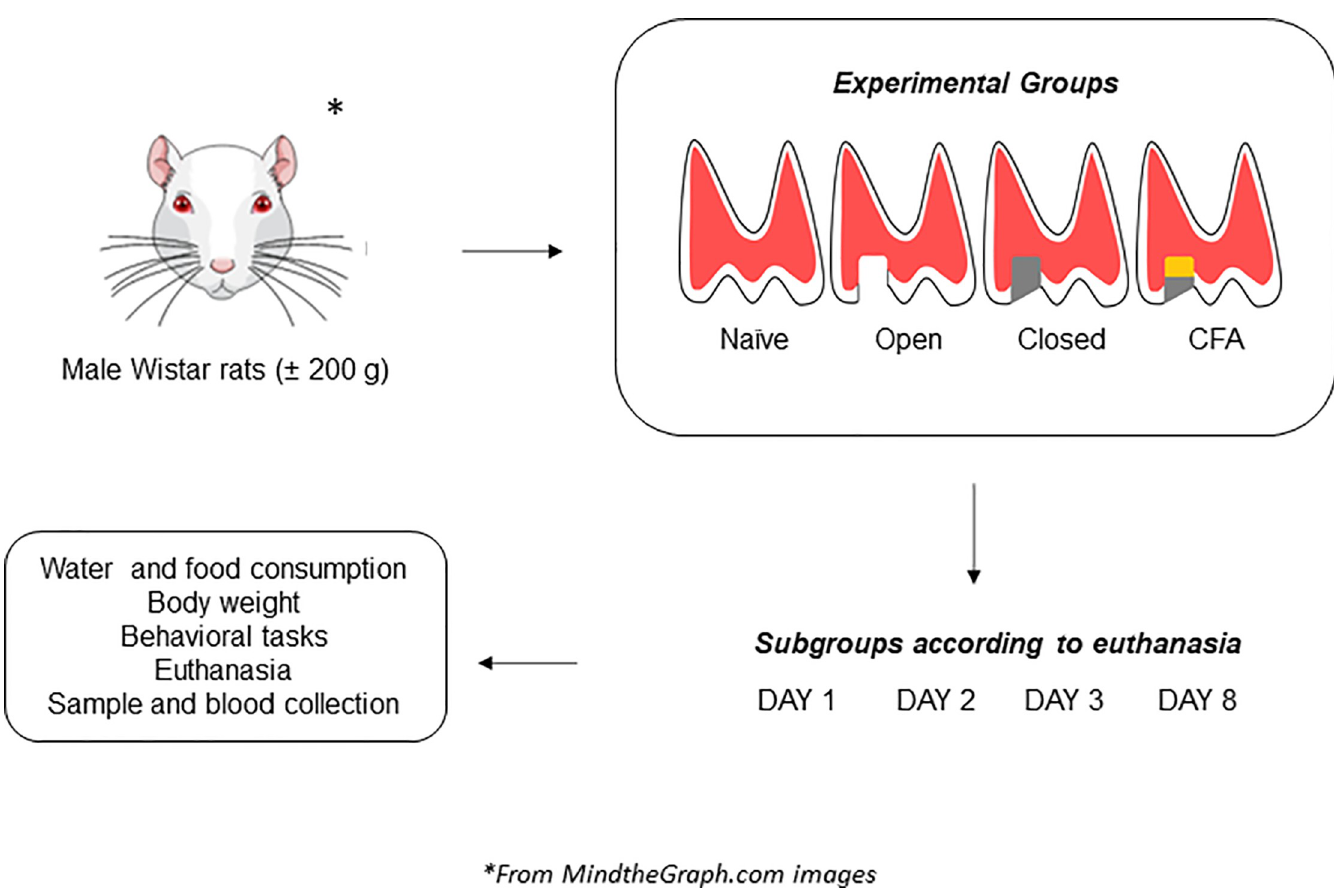
Fig 1. Representation of the general protocols used in the present study. The rats were assigned into four experimental groups, namely na ï ve, open, closed or CFA. Distinct subgroups were euthanized at 1, 2, 3, or 8 days after the tooth pulp intervention. Several parameters were evaluated in each experimental time, and the appropriate samples were